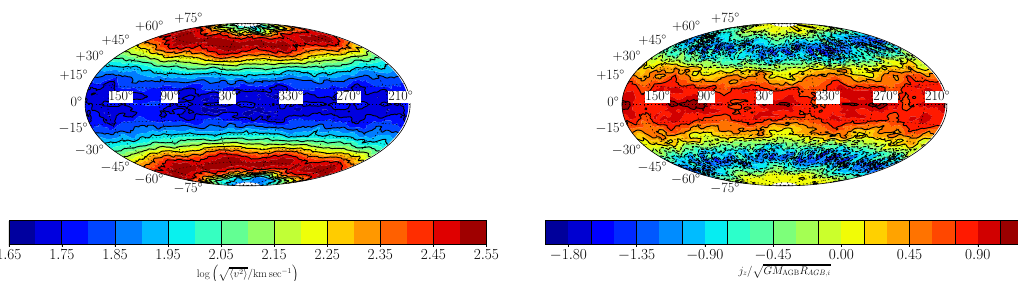
Figure 2. Left panel : The average speed of the outflow at a spherical shell of radius 4 AU for a simulation of the onset of the grazing envelope evolution with jet velocity of 400 km s − 1 and jet’s half-opening angle of 15 ◦ . Right panel : The average specific angular momentum in the z -direction (perpendicular to the orbital plane) in the same sphere of the same simulation. The average specific angular momentum is divided by the initial specific orbital angular momentum of the binary system. Zero latitude is the equatorial (orbital) plane and zero longitude (at the center) is the initial location of the companion. The companion is moving towards higher angles, namely from the right to the